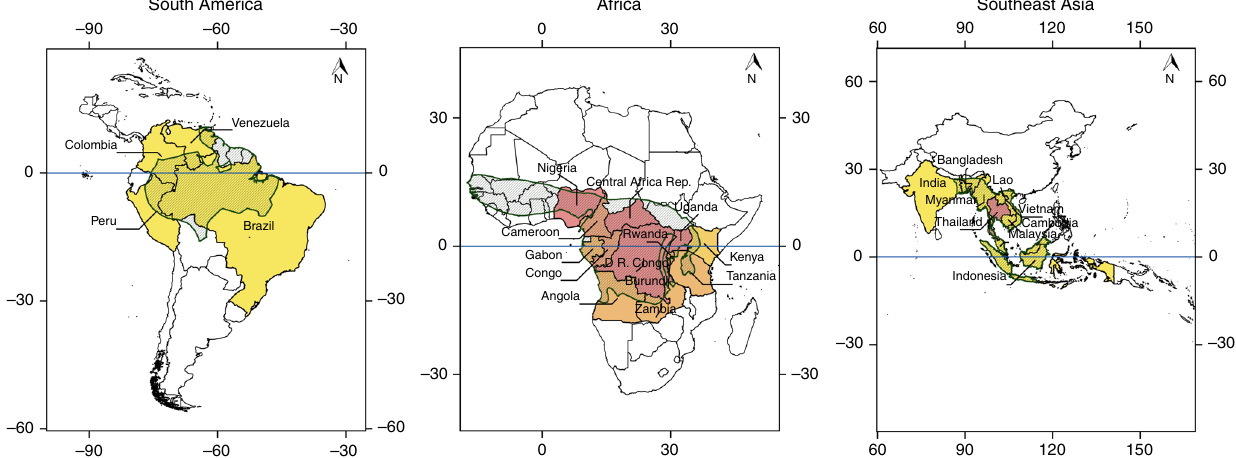
Fig. 1 Malaria incidence by country in the world ’ s three largest rainforests, overlaid with deforestation frontier. Shaded countries: Populations at risk (cases per 1000 population at risk from 2000 – 2015) (yellow <140, orange 140 – 200, light brown 200 – 270, dark brown >270). Hatched areas: deforestation frontiers. Further detail in Methods. Software used: QGIS version 2.8 without any changes. QGIS is licensed under Creative Commons Attribution-ShareAlike 3.0 licence (CC BY-SA)